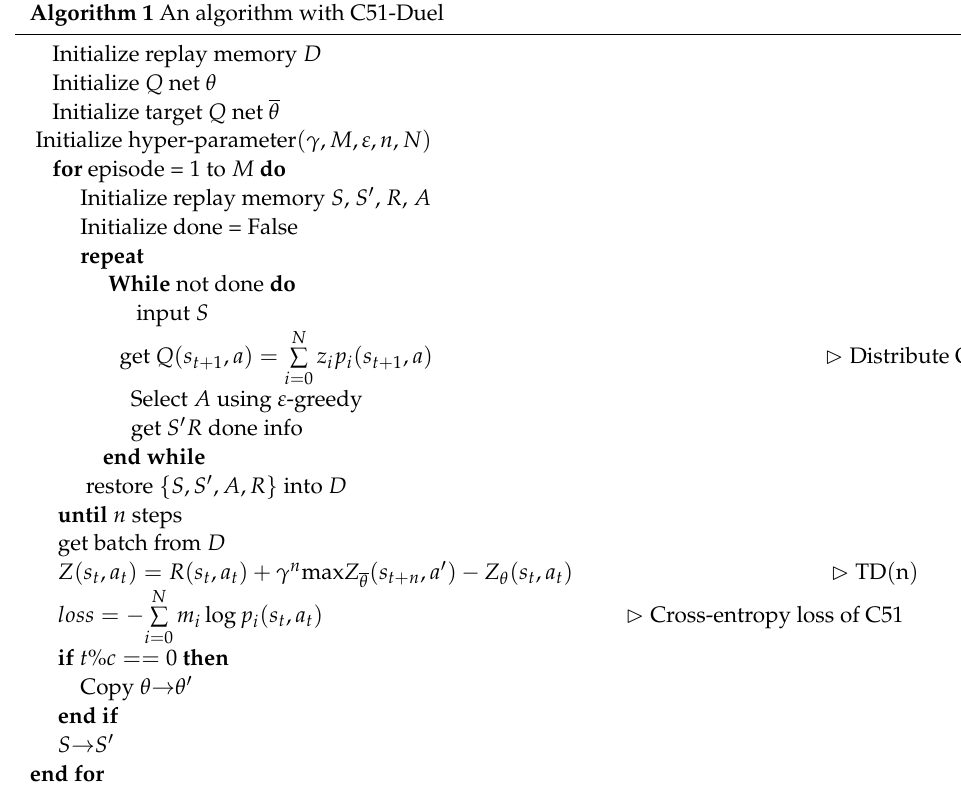
Algorithm 1 An algorithm with